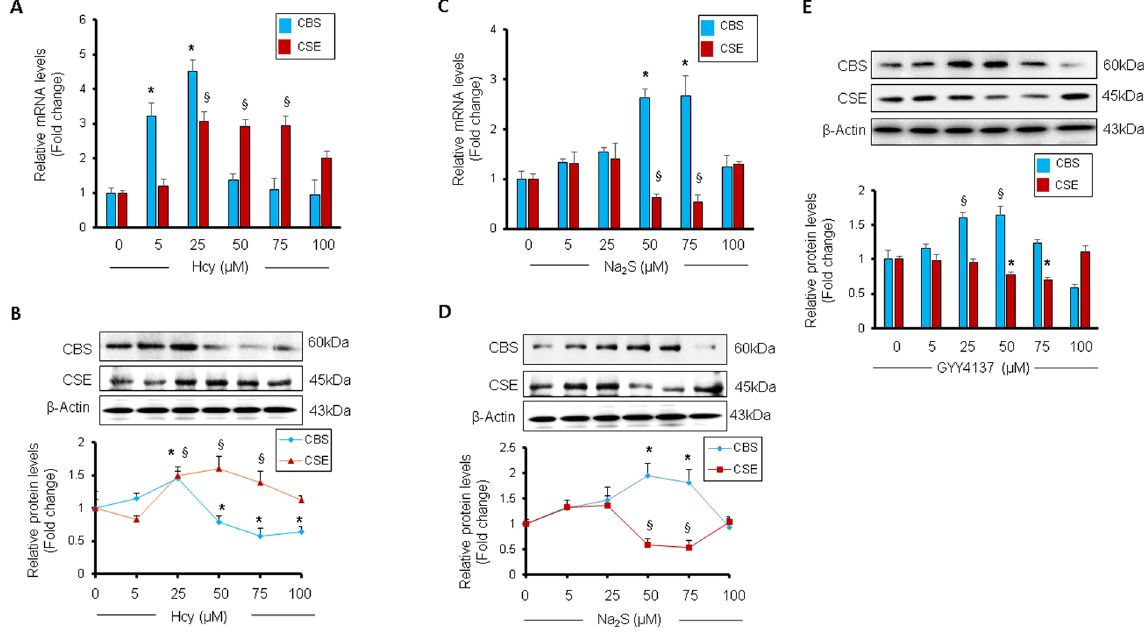
Figure 1. Dose-dependent effect of homocysteine or hydrogen sulfide donor Na 2 S or GYY4137 (H 2 S donor) on CBS and CSE levels in HL1 cardiomyocytes. ( A ) qPCR analyses of CBS and CSE after treatment with different dosages of homocysteine (Hcy), or ( C ) Na 2 S. ( B ) Western blot analyses of CBS and CSE after treatment with different doses of homocysteine (Hcy), or ( D ) Na 2 S. ( E ) Western blot analyses of CBS and CSE after treatment with different doses of GYY4137. Values are represented as mean ± SEM. “ * ” represents statistically